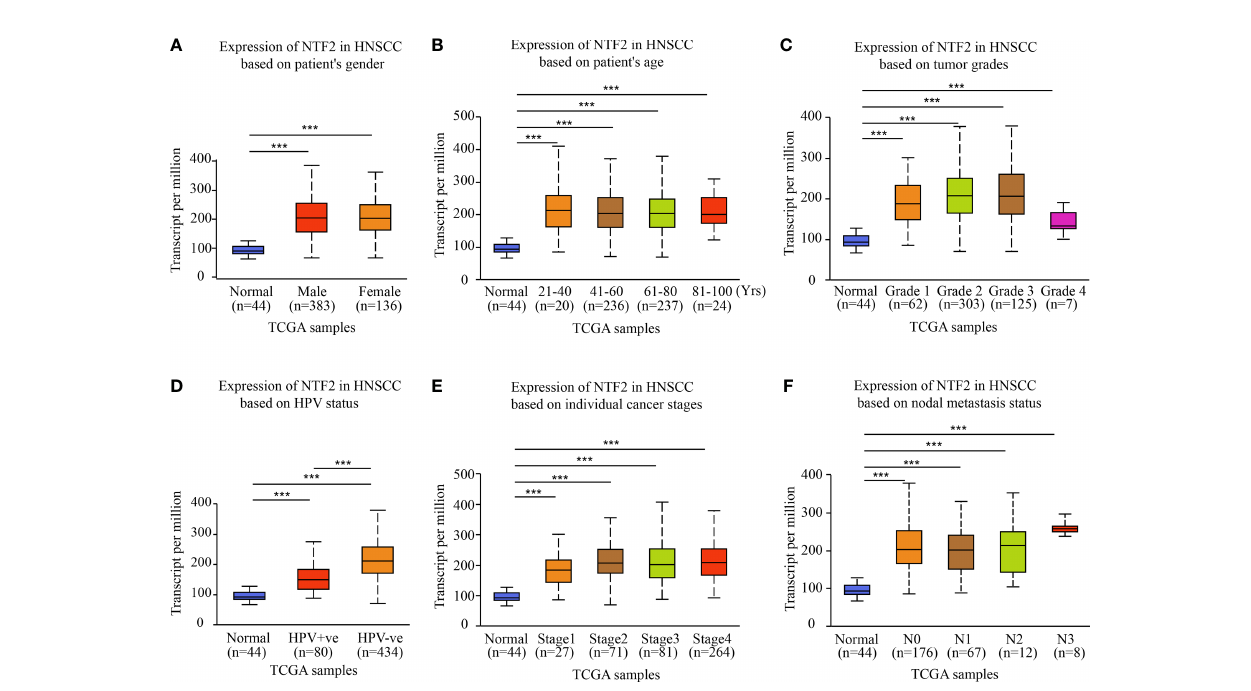
FIGURE 2 | NTF2 expressions in different groups were evaluated according to clinical features based on UALCAN database. Analysis was shown for sex (A) , age (B) , pathological grade (C) , HPV infection (D) , clinical-stage (E) , and lymph node metastasis status (F) . N0: no regional lymph node metastasis; N1: 1 to 3 cervical lymph nodes metastasis; N2: 4 to 9 cervical lymph nodes metastasis; N3: 10 or more cervical lymph nodes metastasis. ***P <